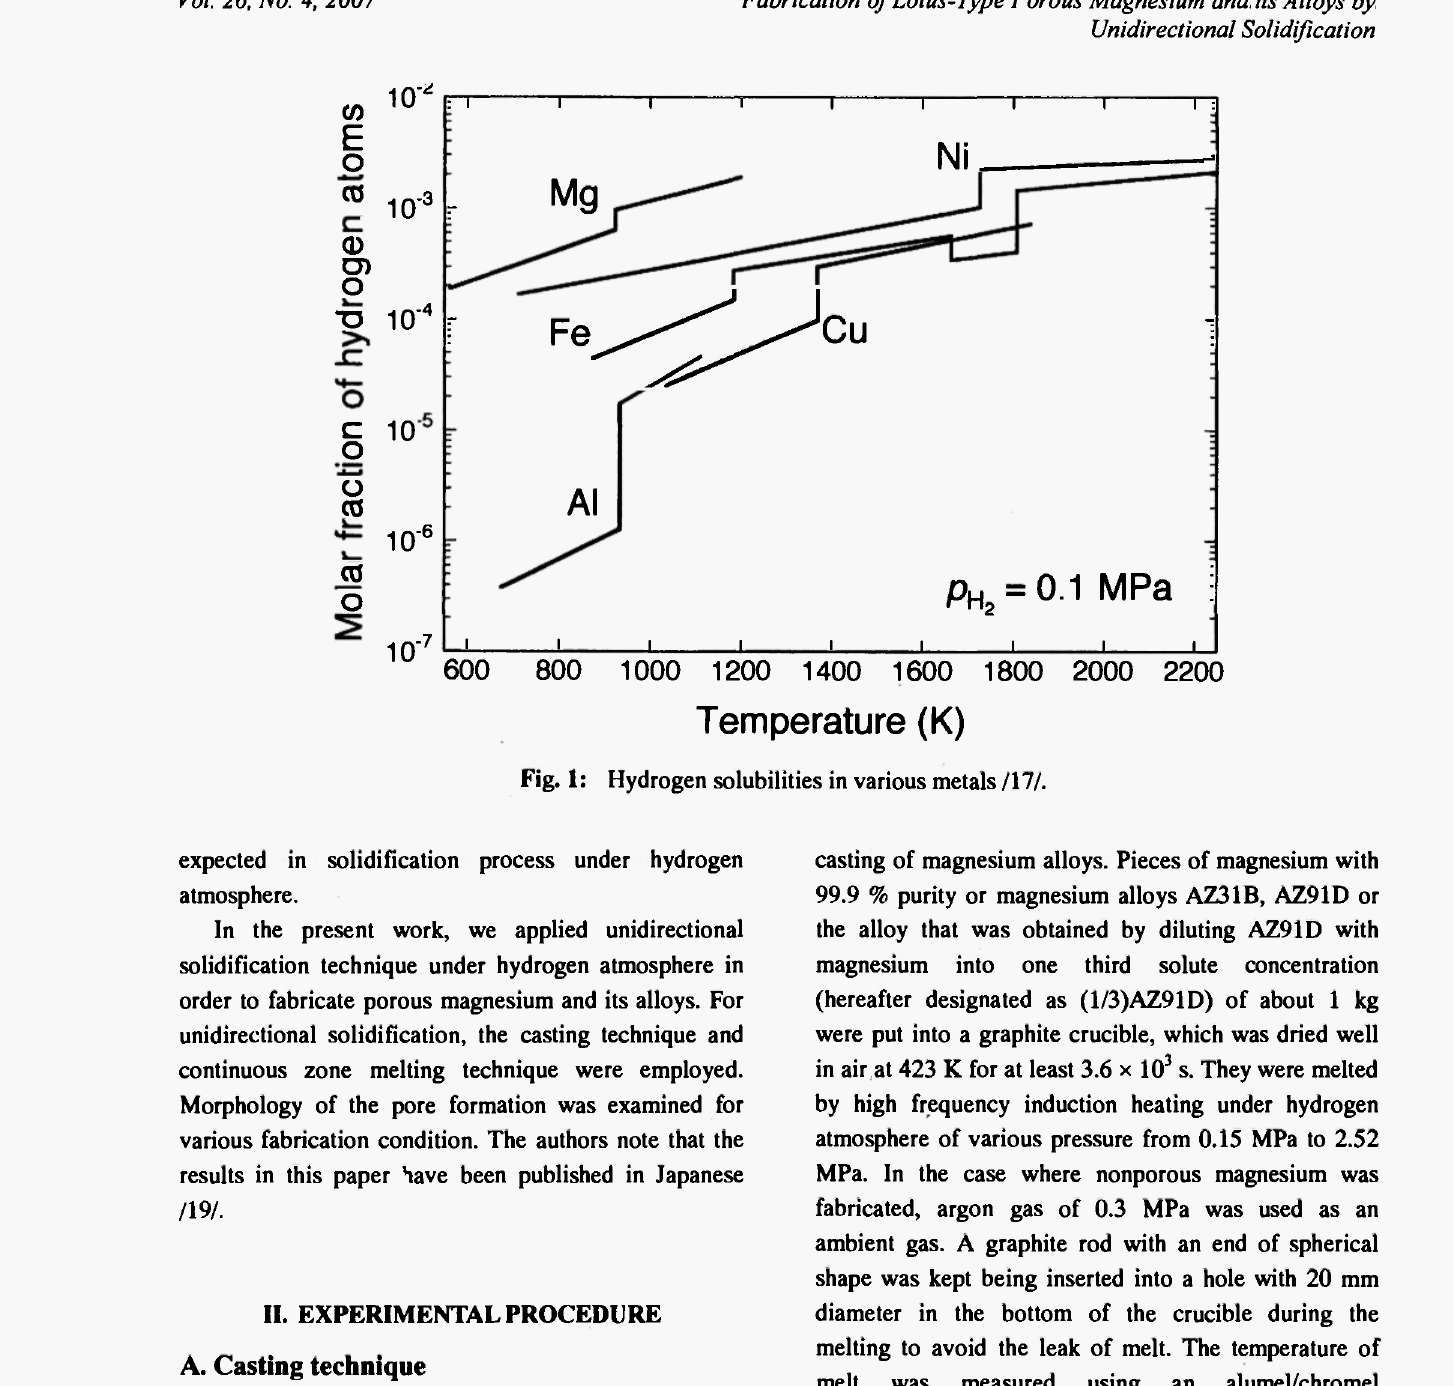
Fig. 1: Hydrogen solubilities in various metals